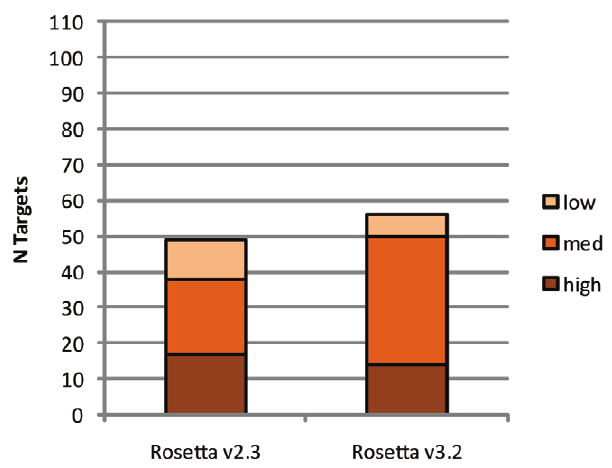
Figure 5. Comparison of RosettaDock v3.2 and RosettaDock v2.3. A histogram showing the docking success and accuracy for a benchmark set of 116 targets for the new RosettaDock v3.2 and the older RosettaDock v2.3.